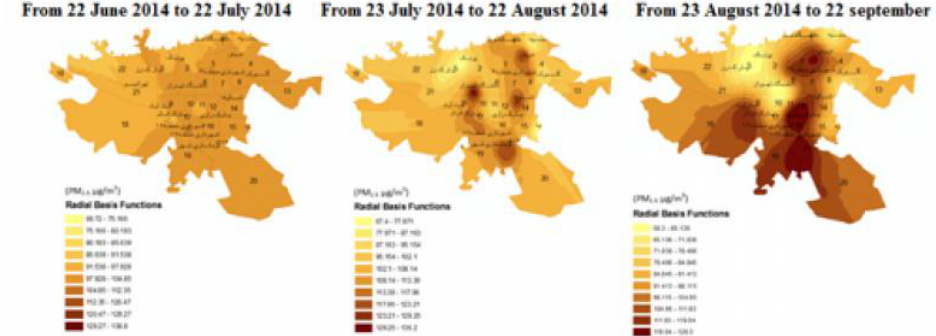
Fig. 4: Model results of fine particulate air pollution contours map using RBF-based approach for PM three months of summer season in